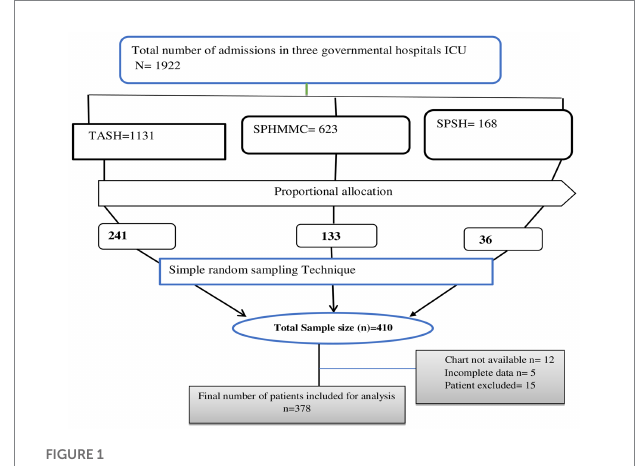
FIGURE 1 Flow diagram of proportional allocation and sampling of study